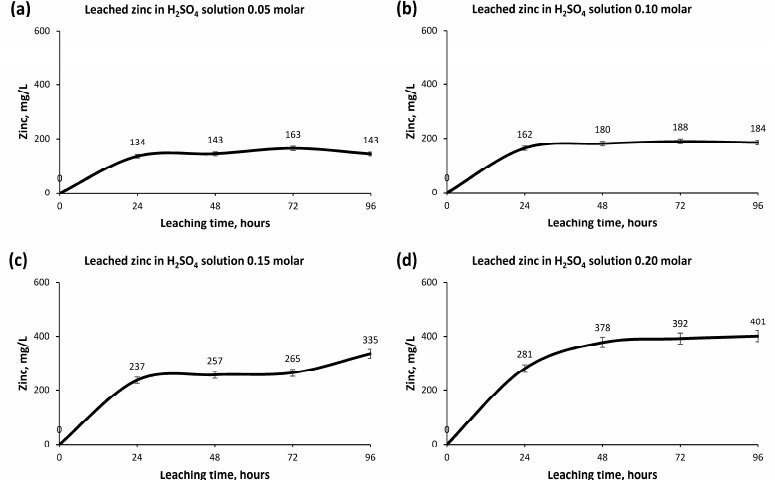
Figure 7. Analysis of Zinc concentration in the leaching process at atmospheric pressure, ambient temperature and in different Sulphuric Acid solutions: ( a ) 0.05 molar H 2 SO 4 solution, (b) 0.10 molar H 2 SO 4 solution, ( c ) 0.15 molar H 2 SO 4 solution and ( d ) 0.20 molar H 2 SO 4 solution.